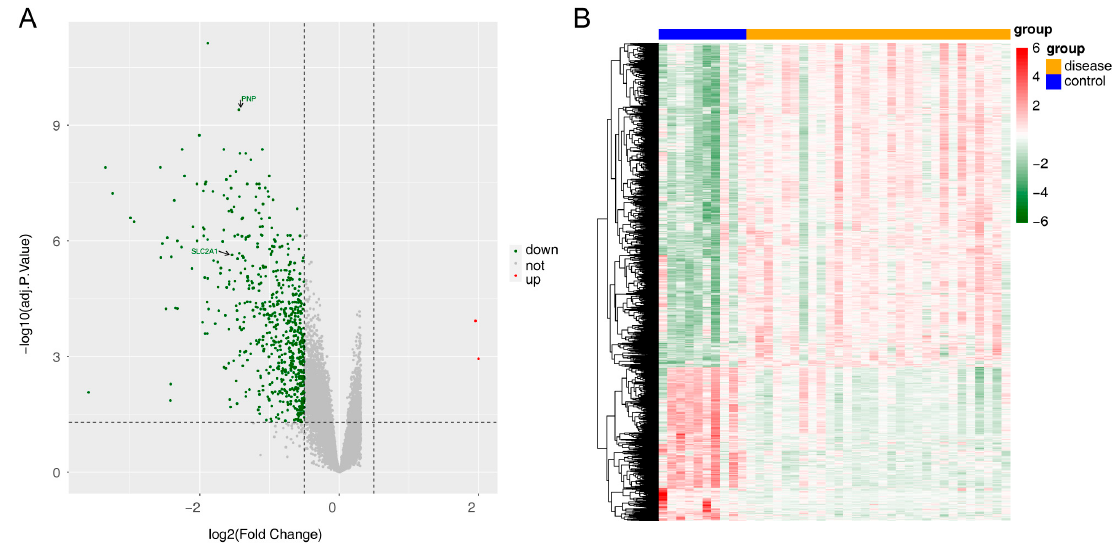
Figure 2. Identification of a total of 2036 differential expressed SONFH genes (DE-SONFHGs) between SONFH samples and control samples in the GSE123568 dataset. Volcano map ( A ) and heatmap ( B ) of 2036 DEGs.